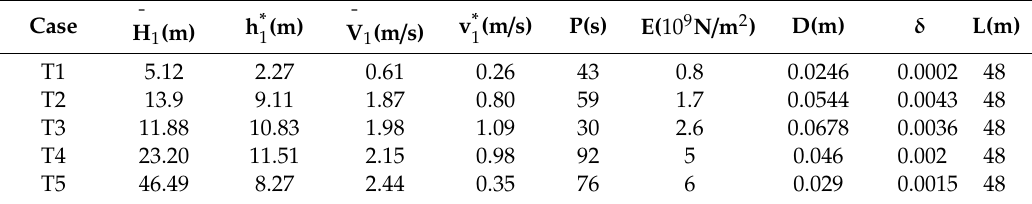
Table 6. Physical parameters of oscillating water flow and pipe used in the validation